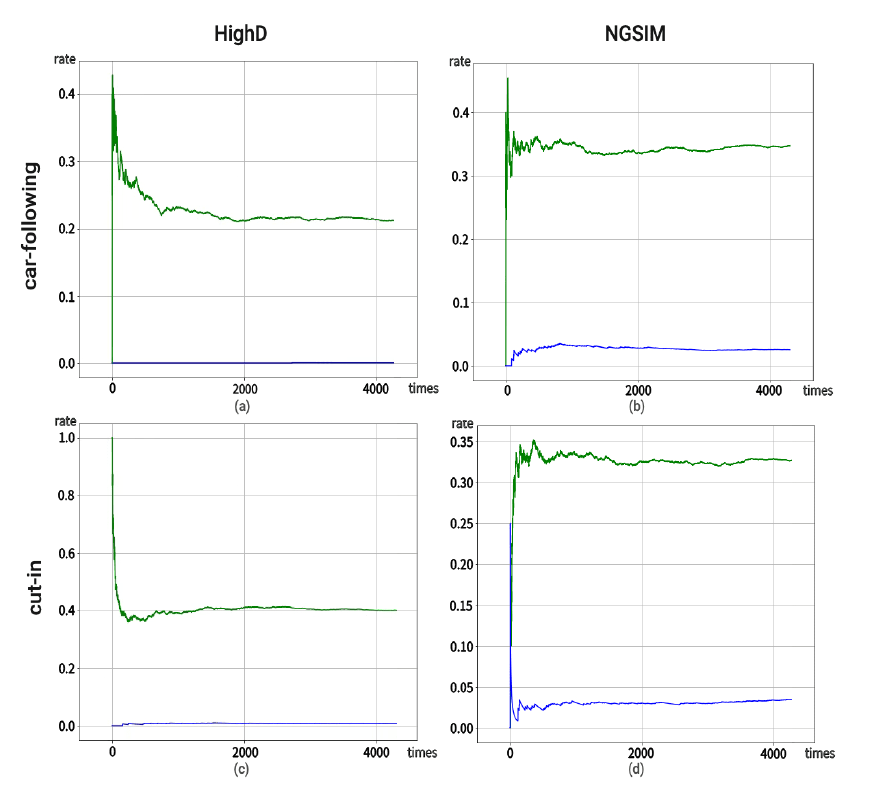
Figure 7. The simulation results of the car-following case and cut-in case using ( a , c ) HighD and ( b , d ) NGSIM